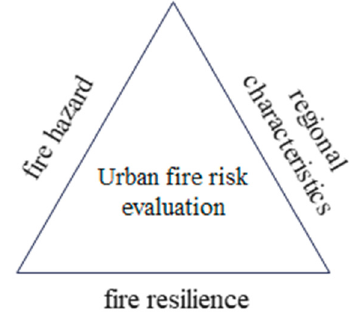
Figure 2. Triangle theoretical model of urban fire risk evaluation.